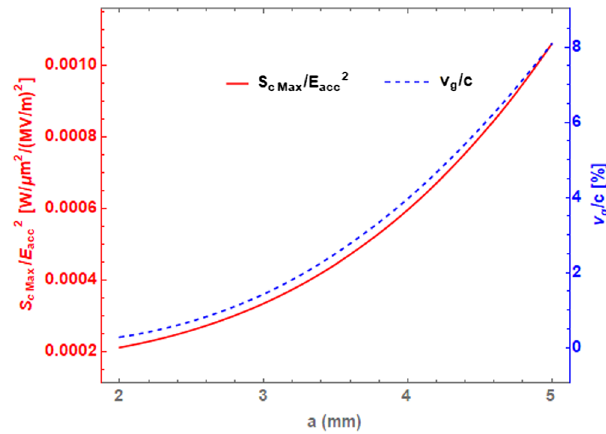
FIG. 6. The maximum modified Poynting vector normalized to the square of the accelerating electric field S =c of the single cell tuned to 11.9942 GHz in the 2 π = 3 velocity v g mode as a function of iris cell a